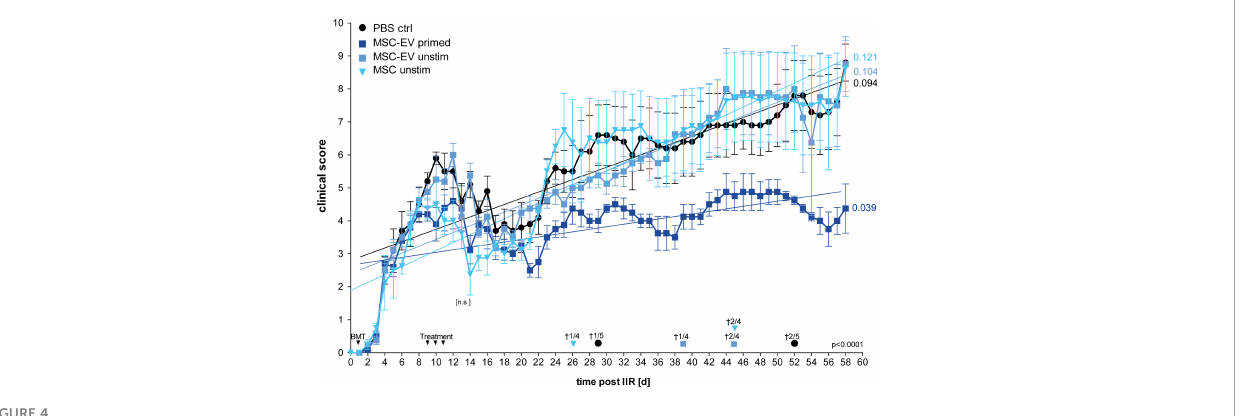
FIGURE 4 Primed MSC-EVs show long-term bene fi cial therapeutic effects compared to unprimed MSCs. Balb/c mice were lethally irradiated (day 0) and injected with CD90.2 depleted bone marrow cells and naïve CD4 cells from C57BL/6J mice to induce GvHD (day 1). Treatment with MSC-EVs were performed at day 9, 10 and 11. MSC cells were injected at day 9. Time fl owchart of clinical score. Day of deaths and remaining mice per group as indicated. Numbers at the end of linear regressions indicate the slope. P value indicates statistical differences between the groups, [n.s.] on day 13, indicates no signi fi cant difference between the groups two days after last treatment, One-way ANOVA with Tukey ’ s multiple comparison test was used to test statistical signi fi cance. Data is shown as center value: mean error bars: